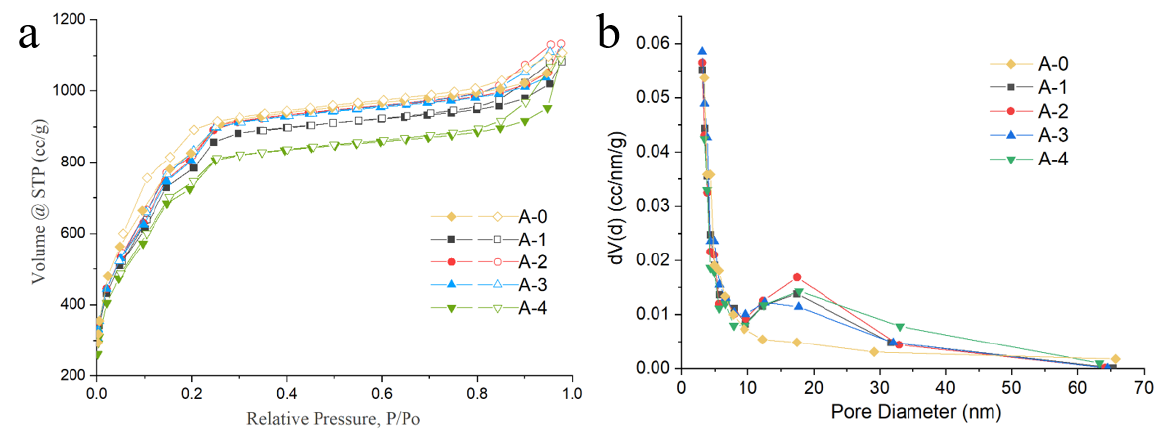
Figure 2. ( a ) Nitrogen adsorption and desorption curves of samples. ( b ) BJH pore size distribution curves of each sample. Table 1. The pore structure information of each sample.